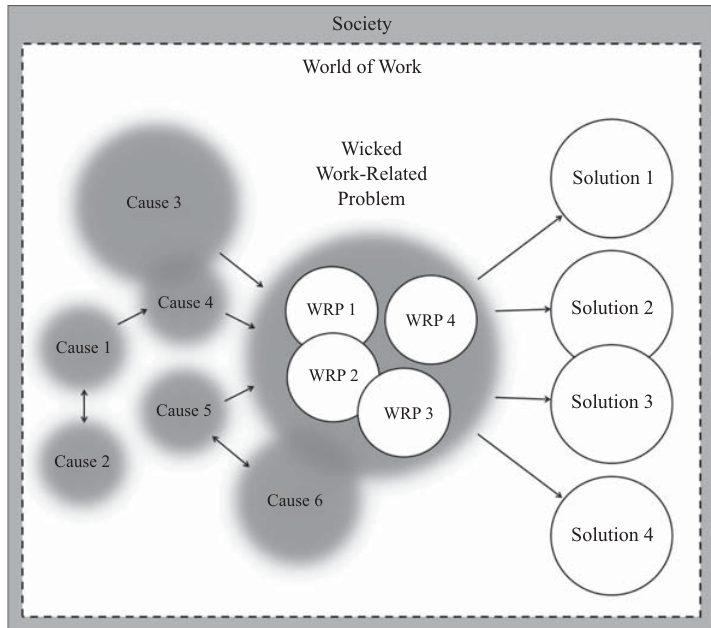
Figure 4. Proto-theoretical model of a wicked work-related